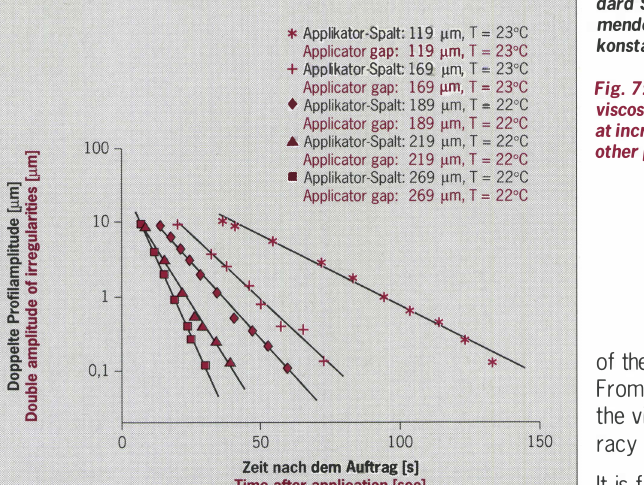
of the uncertainty raised to the third power. From these data one can therefore conclude that the viscosity can be determined with an accu­ racy of ± 10 %.